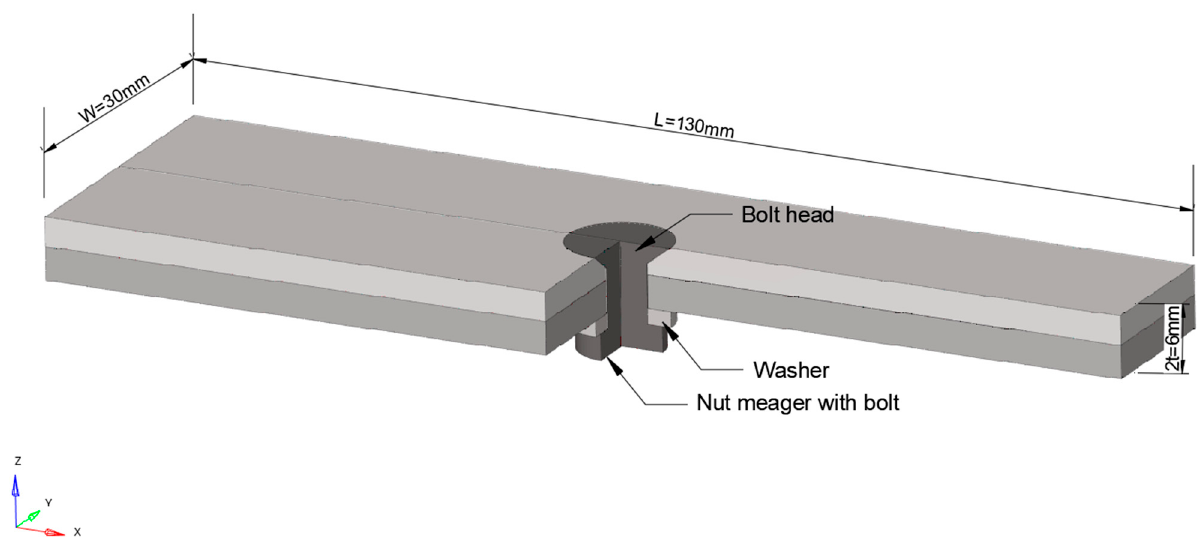
Figure 5. Schematic diagram of the geometry.